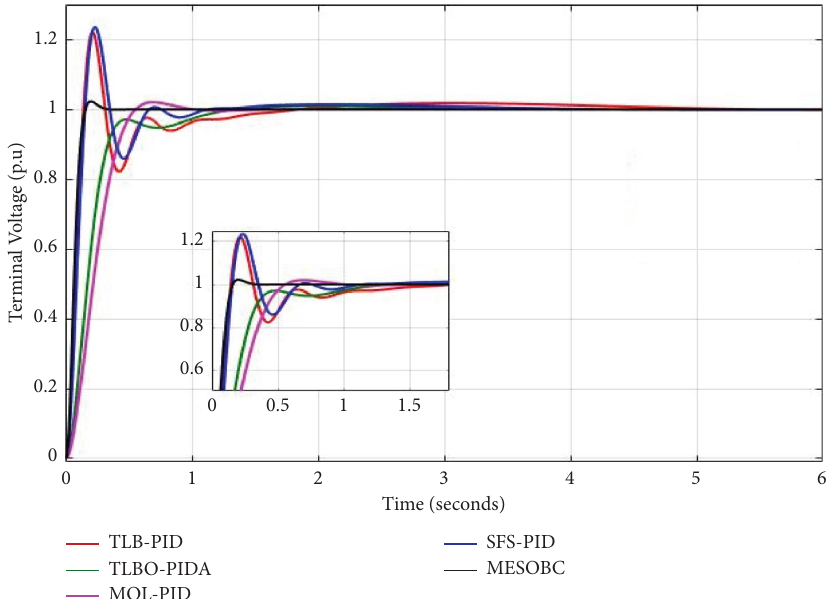
Figure 3: Response of terminal voltage under normal